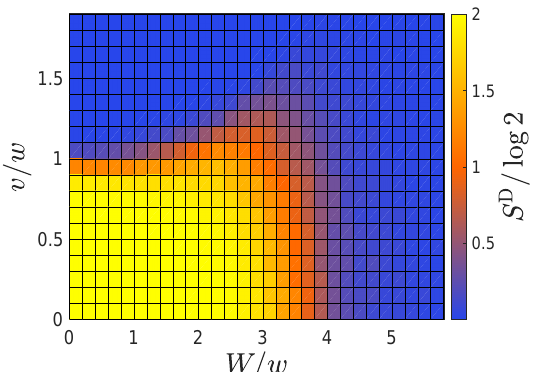
Figure 5: (Color online) Phase diagram of the SSH model obtained with S D for the uniform disorder of Eq. 29 with 2 W averaged over 400 realizations for each point. The “bump” of the topological phase (in yellow) constitutes the topological Anderson insulator